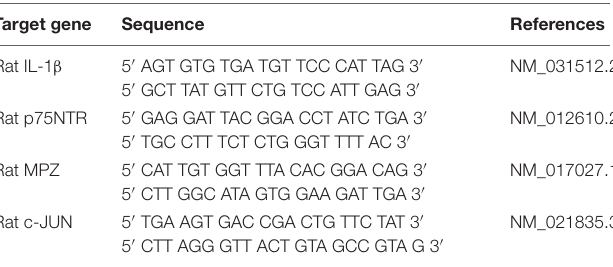
TABLE 1 | List of oligonucleotides used for quantitative real time